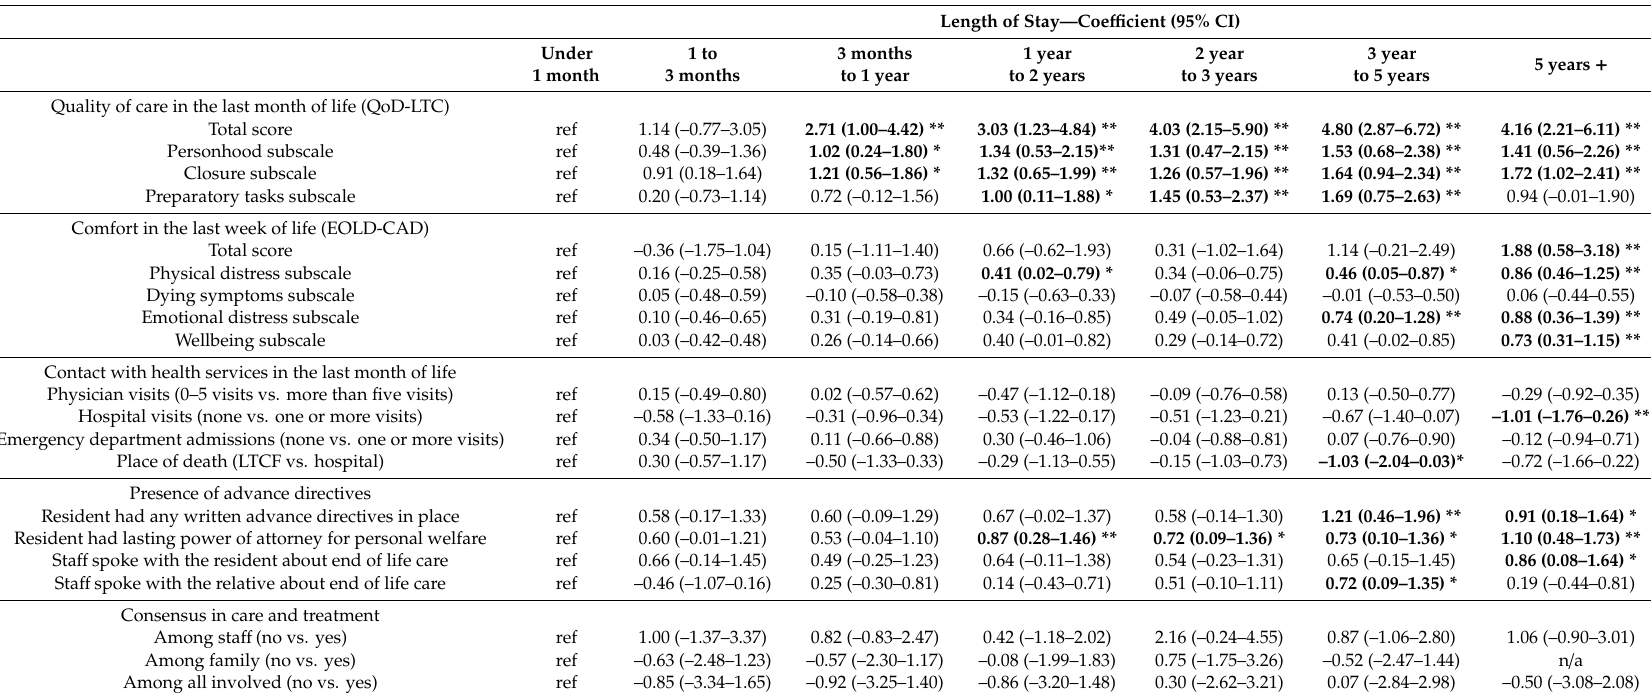
Table 3. Associations between indicators of end of life care of deceased LTCF and length of stay in a LTCF until